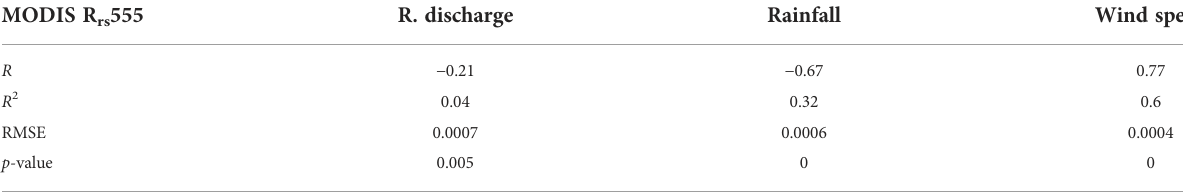
TABLE 1 Statistical outputs of the regression of MODIS Rrs 555 against river discharge, rainfall in Zambezi Delta, and wind speed. MODIS R rs 555 R.